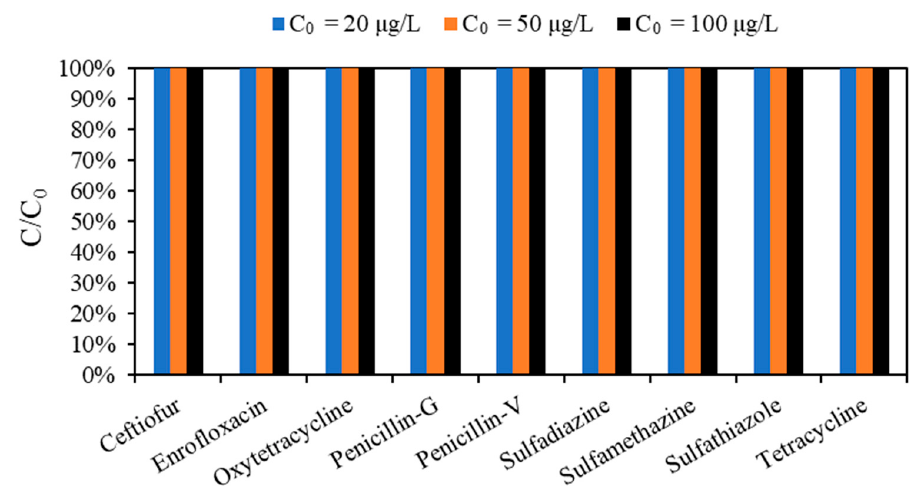
Figure 5. Effects of antibiotics concentration using UV/TiO 2 photocatalysis for 30 min: Same degradation efficiency at all initial concentration of antibiotics after 30 min illumination.